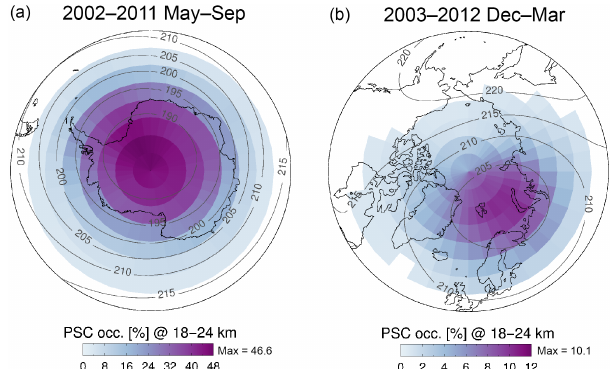
Figure 6. Occurrence of PSC spectra with respect to the total num- ber of measured spectra in the complete MIPAS measurement pe- riod for SH (a) and NH (b) polar winter conditions. A mean for May–September and December–March for 2002–2011 of ERAi- based temperature contours at 50hPa is superimposed in grey. Please note the different ranges of the colour bar for both